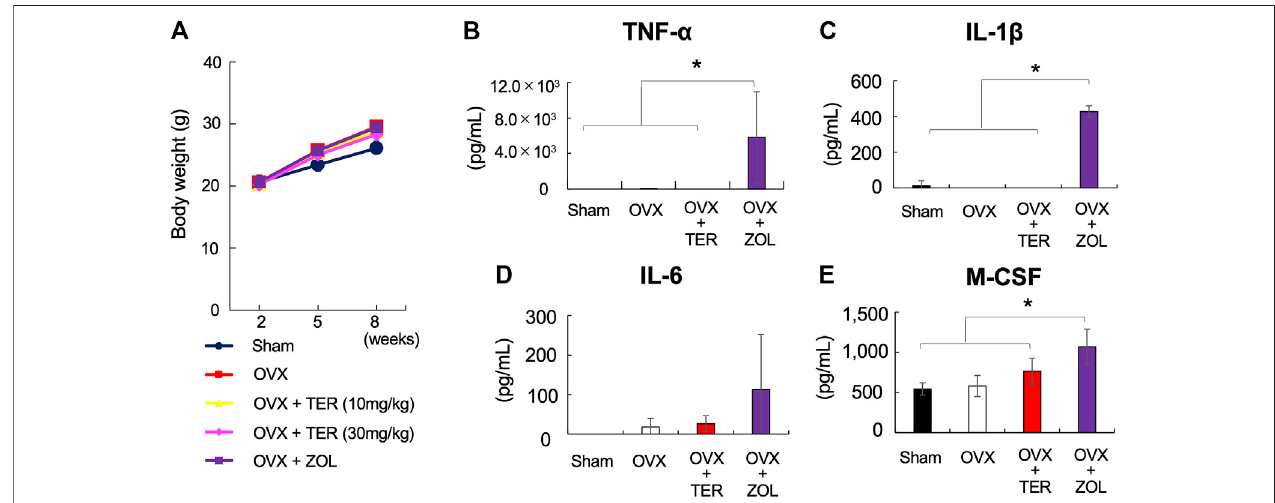
FIGURE 5 | Synthetic TER did not affect the body weight and serum in fl ammatory cytokines production. (A) Effect of synthetic TER on body weight. Weight changesinSham,OVX,OVX+TER(10 – 30 mg/kg, twotimesaweek),andOVX+zoledronicacid(ZOL,0.1 mg/kg,twotimes aweek)groupswereobservedupto2,5, and 8 weeks after the start of the experiment as relative values (mean ± SD) of the baseline body weight value (100%) at the start of the experiment ( n (cid:1) 4 – 7). The error bar: SD. (B – E) The amount of pro-in fl ammatory cytokines (TNF- α , IL-1 β , IL-6, and M-CSF) in the serum was quanti fi ed using ELISA ( n (cid:1) 4 – 7). Columns represent the mean results of the experiments carried out in, at least, triplicates, and the bars represent the SD ( n (cid:1) 4 – 7, * p < 0.05, ANOVA/Tukey – Kramer test).